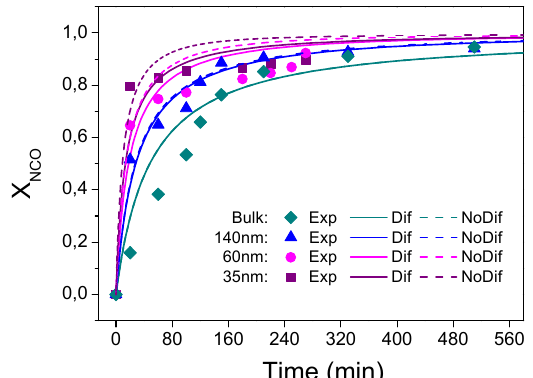
Figure 10. Conversion versus time of polyurethanes polymerized in bulk, as well as in 35, 60 and 140 nm pores at 80 °C. Symbols indicate experimental data, and solid and dotted lines show diffusion (Dif) and no diffusion (NoDif) model predictions ([136]). Copyright 2018. Reproduced with permission from the publisher: Elsevier.